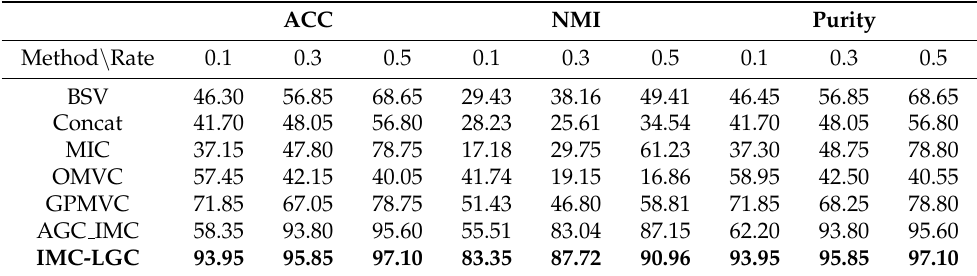
Table 3. Average values of ACC (%), NMI (%), and purity (%) of different methods on the handwritten dataset with different observed rates of paired samples. Bold numbers denote the best